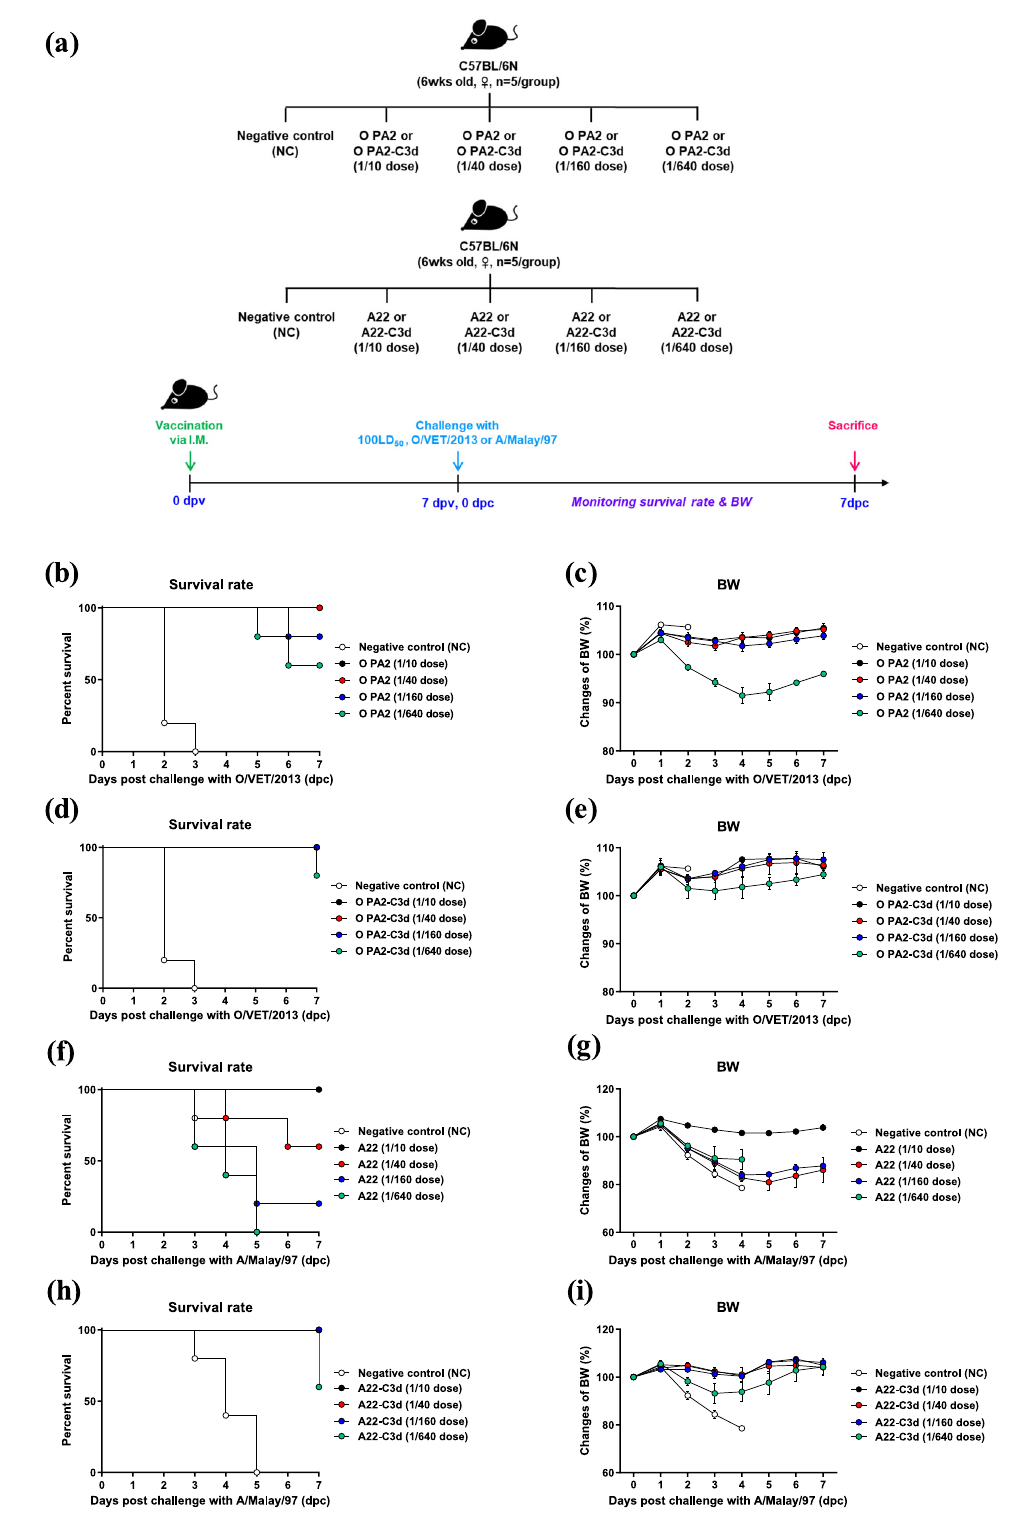
Fig. 2 Vaccine ef fi cacy and protective effects of O PA2-C3d and A22-C3d in mice. C57BL/6 mice ( n = 5/group) were administered the test vaccine at 1/10, 1/40, 1/160, 1/640 doses of O PA2 or O PA2-C3d or A22 or A22-C3d antigen for cattle or pig use, ISA 206 (oil-based emulsion, 50%, w/w), 10% Al(OH) 3 , and 15 µg Quil-A. A negative control (NC) group was injected with the same volume of PBS. The test vaccines were injected intramuscularly into mice that were later challenged with FMDV type O (100 LD 50 O/VET/2013) or FMDV type A (100 LD 50 A/Malay/97) at 7 dpv. The survival rates and body weights were monitored for 7 dpc. ( a – i ) Experimental strategy ( a ); survival rates post-challenge with O/ VET/2013 ( b , d ) or A/Malay/97 ( f , h ); changes in body weight post-challenge with O/VET/2013 ( c , e ) or A/Malay/97 ( g , i ). The data represent the mean ± SEM of triplicate measurements ( n =